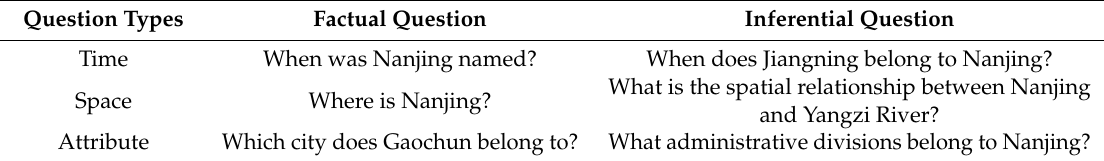
Table 2. Questions to the GeoKG model and The YAGO